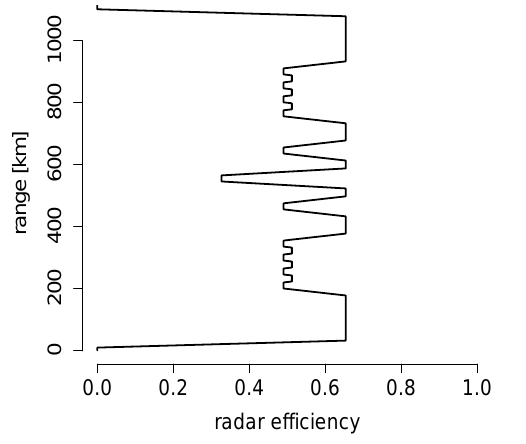
Fig. 4. Radar efficiency for experiment 1 introduced in this paper.